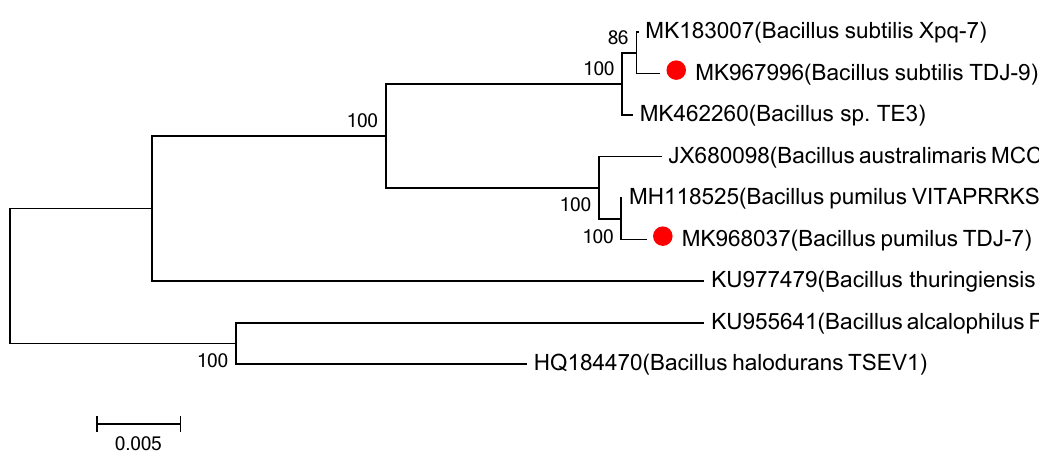
Figure 2. The curve on degradation of terbutylazine by different